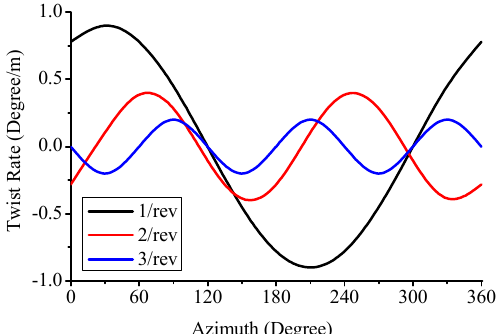
Figure 13. Optimal control schedules of uniform twist control with the 1~3/rev inputs for condition B.